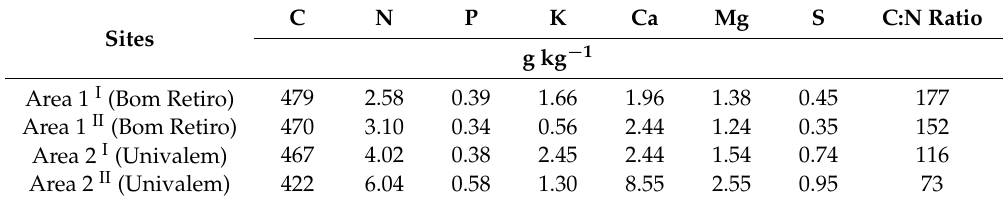
Table 3. Carbon (C) and macronutrient (nitrogen—N, phosphorus—P, potassium—K, calcium—Ca, magnesium—Mg, sulphur—S) content of the sugarcane straw used in each